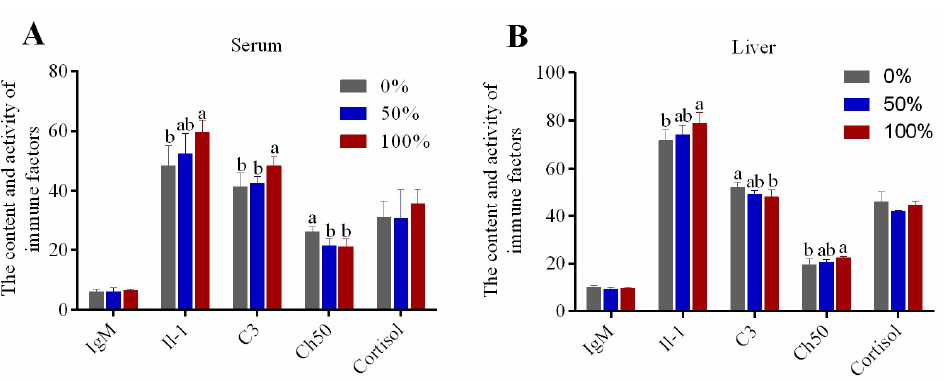
Figure 2. Effect of common reed on content and activity of immune factors in serum ( A ) and liver ( B ) of grass carp (N = 3). The units of IgM, IL-1, C3, CH50 and Cortisol were µ g/mL, pg/mL, µ g/mL, U/mL and ng/mL respectively. Different small letters mean significant difference among groups ( p < 0.05), the same letters or no letters mean no significant difference ( p > 0.05).